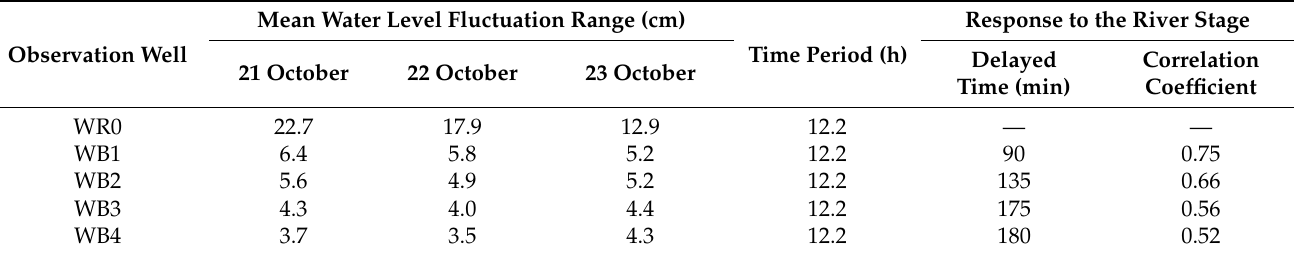
Table 1. Fluctuations and the response relationship of the river stage and the groundwater level during the monitoring period from 21 to 23 October 2021.